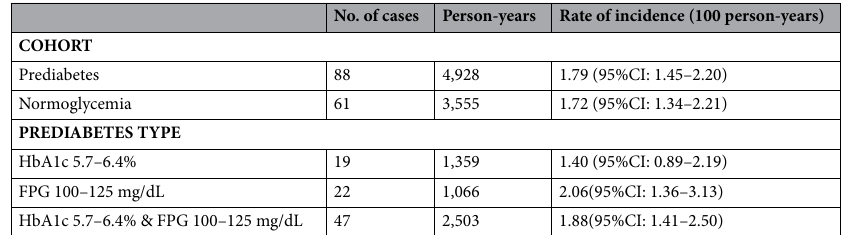
Table 2. Five-year rate of incidence of impaired renal function per 100 person-years by cohort and prediabetes type.